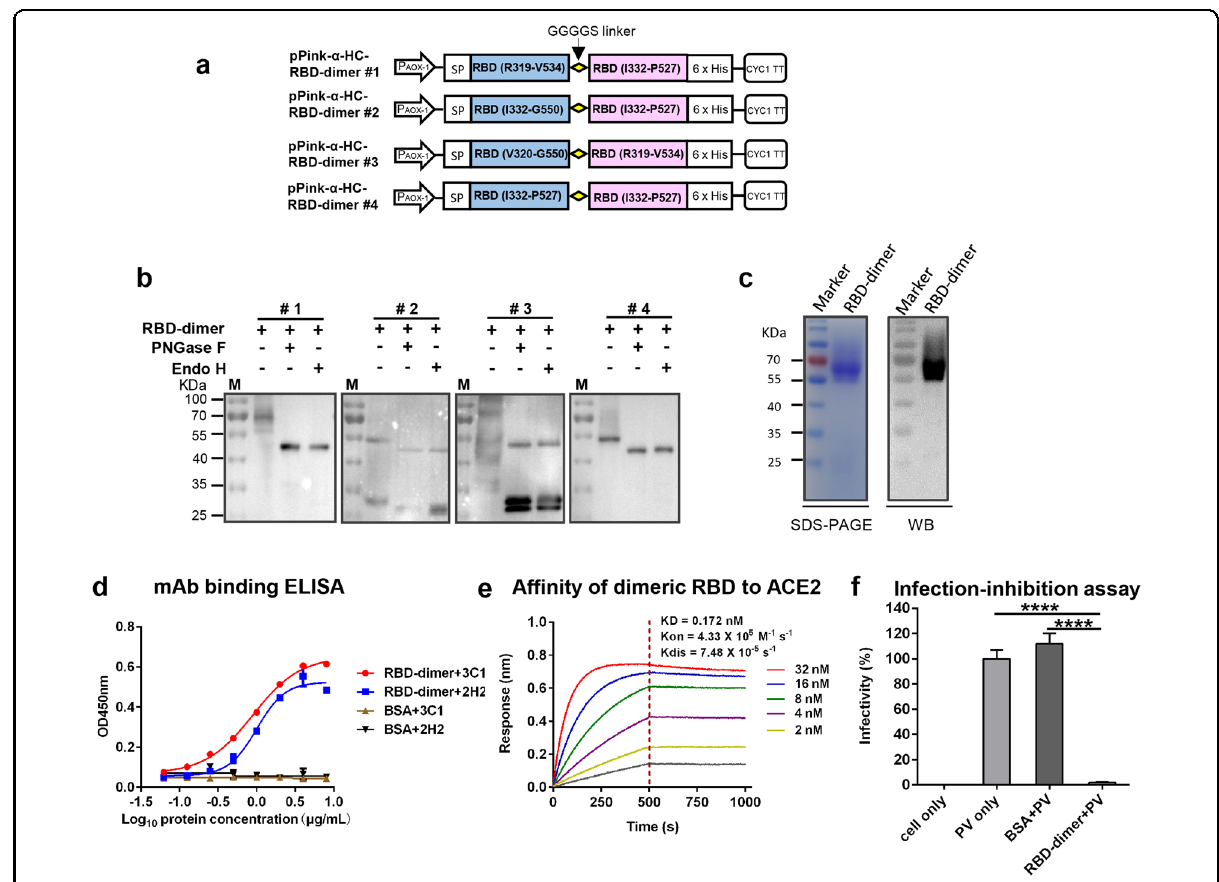
Fig. 4 Production and characterization of recombinant SARS-CoV-2 RBD-dimer in yeast. a Schematic diagram of four expression vectors (designated #1 to #4) encoding tandem-repeat RBD-dimer. b Supernatants of each vector-transformed yeast cultures were digested with either endo H or PNGase F, and then subjected to western blotting analysis with an anti-RBD (inclusion bodies) polyclonal antibody. Symbol ( + ) indicates presence; ( − ) indicates absence. M, protein marker. c RBD-dimer protein was puri fi ed from culture supernatant of a yeast clone transformed with vector #1 and then analyzed by SDS-PAGE (left panel) and western blotting (WB; right panel) with an anti-RBD (inclusion bodies) polyclonal antibody. d Reactivity of RBD-dimer with neutralizing MAbs 2H2 and 3C1 measured by ELISA. BSA served as negative control. Data shown are means ± SEM of triplicate wells. e Binding af fi nity of yeast-derived dimeric RBD to immobilized hACE2-Fc determined by BLI. RBD-dimer protein concentrations tested were shown. f Inhibition of cell entry of SARS-CoV-2 pseudovirus (PV) by dimeric RBD protein. Data are means ± SEM of triplicate wells. Statistical was determined by Student ’ s t -test and indicated as follows: ns, not signi fi cant; **** P <